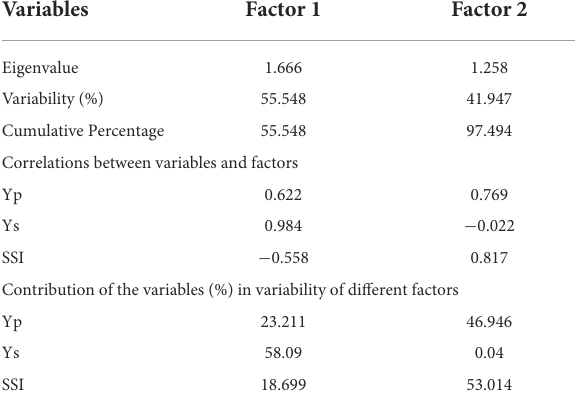
TABLE 2 Eigenvalue, variability, and cumulative variability of different factors; correlations between variables and factors; contribution of the variables (%) in variability of different factors; based on principal component